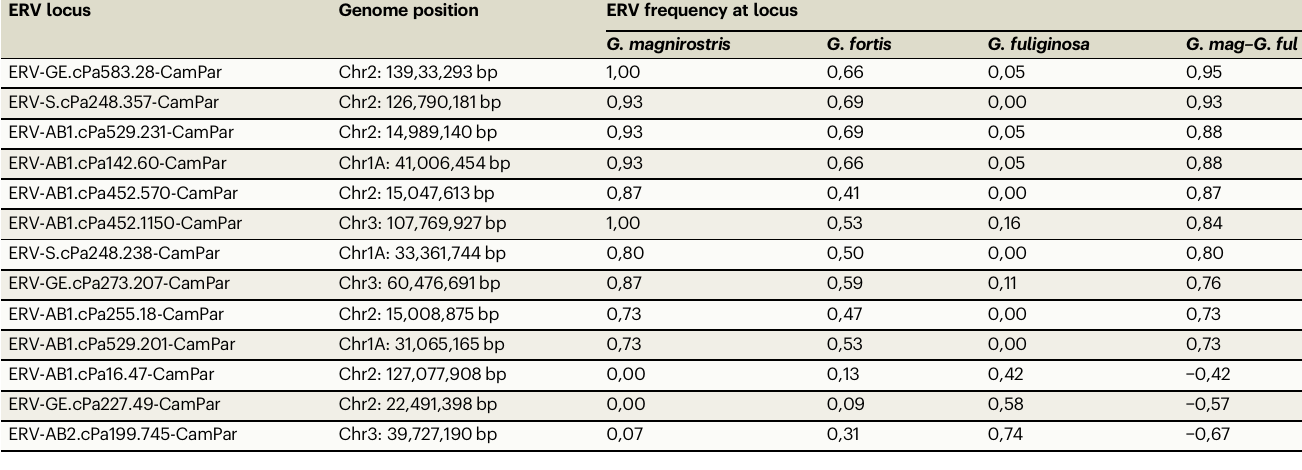
Table 1 | ERV frequency within genomic regions associated with beak